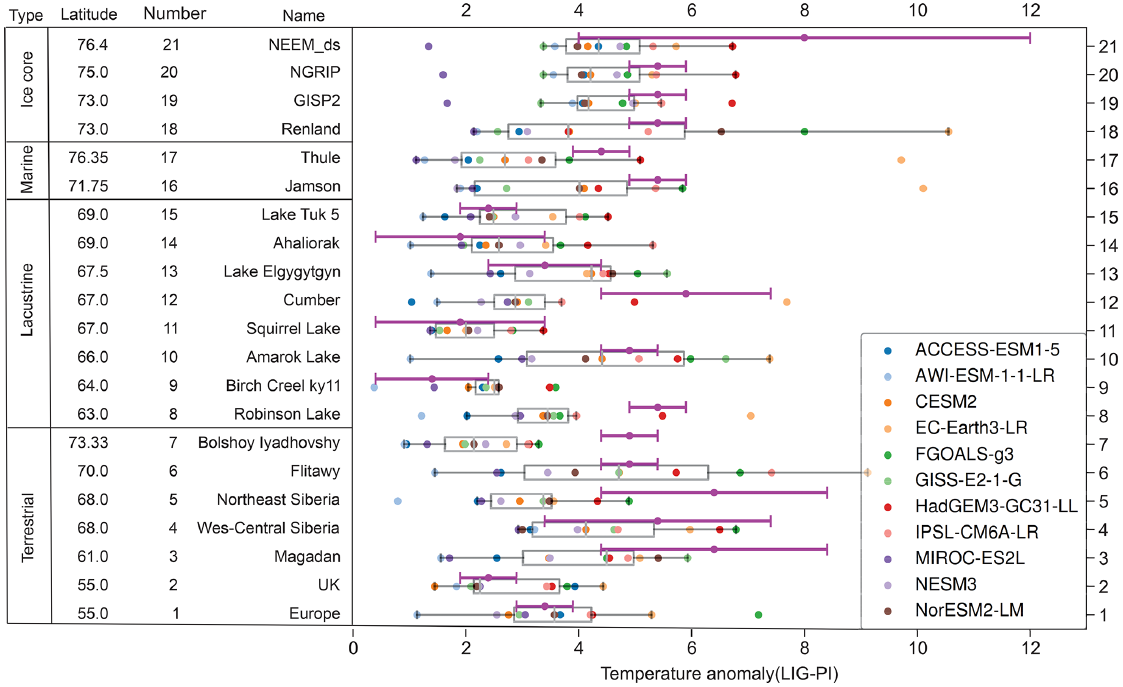
Figure 9. Proxy (cid:49) SSAT (violet dots and uncertainty bars) and simulated (cid:49) SSAT for all models (coloured dots) for each proxy record location (rows). Grey boxes extend from the 25th to the 75th percentile of each location’s distribution of simulated values, and the vertical lines represent the